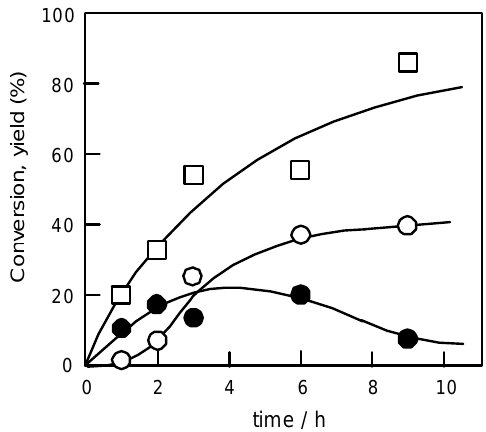
Figure 3. Changes of total conversion and product yields with reaction time. Conversion, ( ); yields of 2 ( ) and 3 ( ).